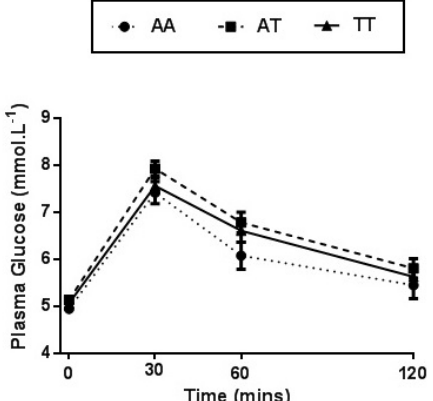
Figure 2. Plasma glucose concentration observed prior to and following an OGL challenge between genotypes for the FTO rs9939609 polymorphism. Values expressed as mean ± SEM. The main effect for time was observed in response to an OGL, p < 0.001.